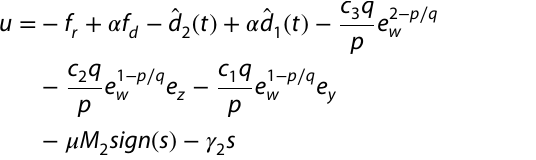
Fig. 1 The initial membership function of input s ( t )